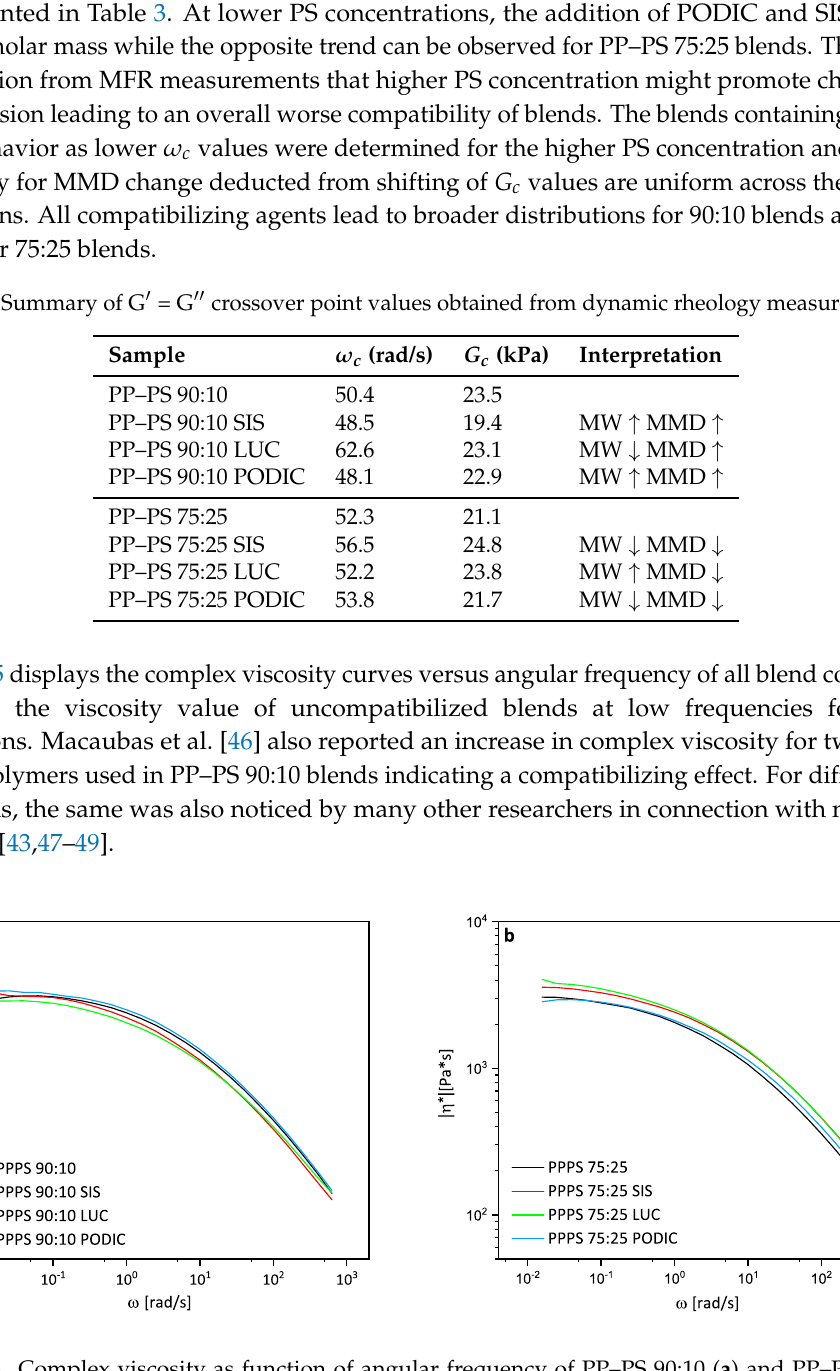
Figure 5. Complex viscosity as function of angular frequency of PP–PS 90:10 ( a ) and PP–PS 75:25 ( b ) blends; measured at 230 ◦